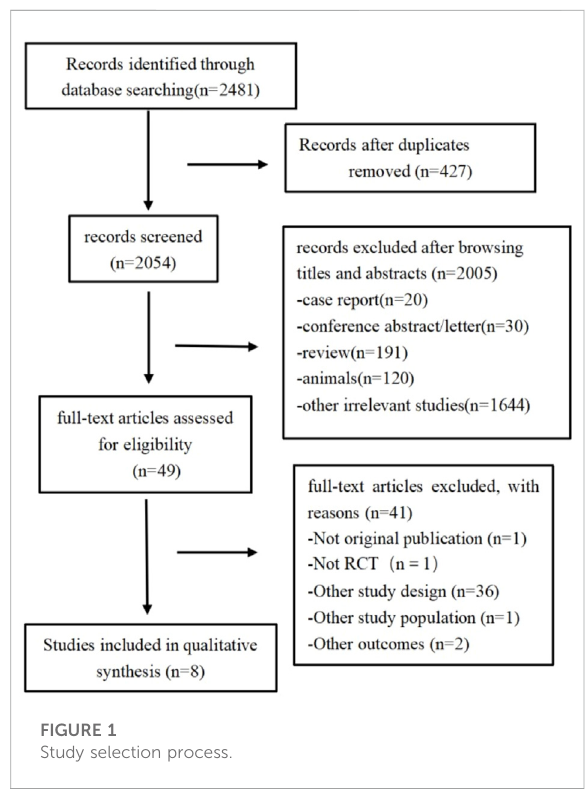
FIGURE 1 Study selection